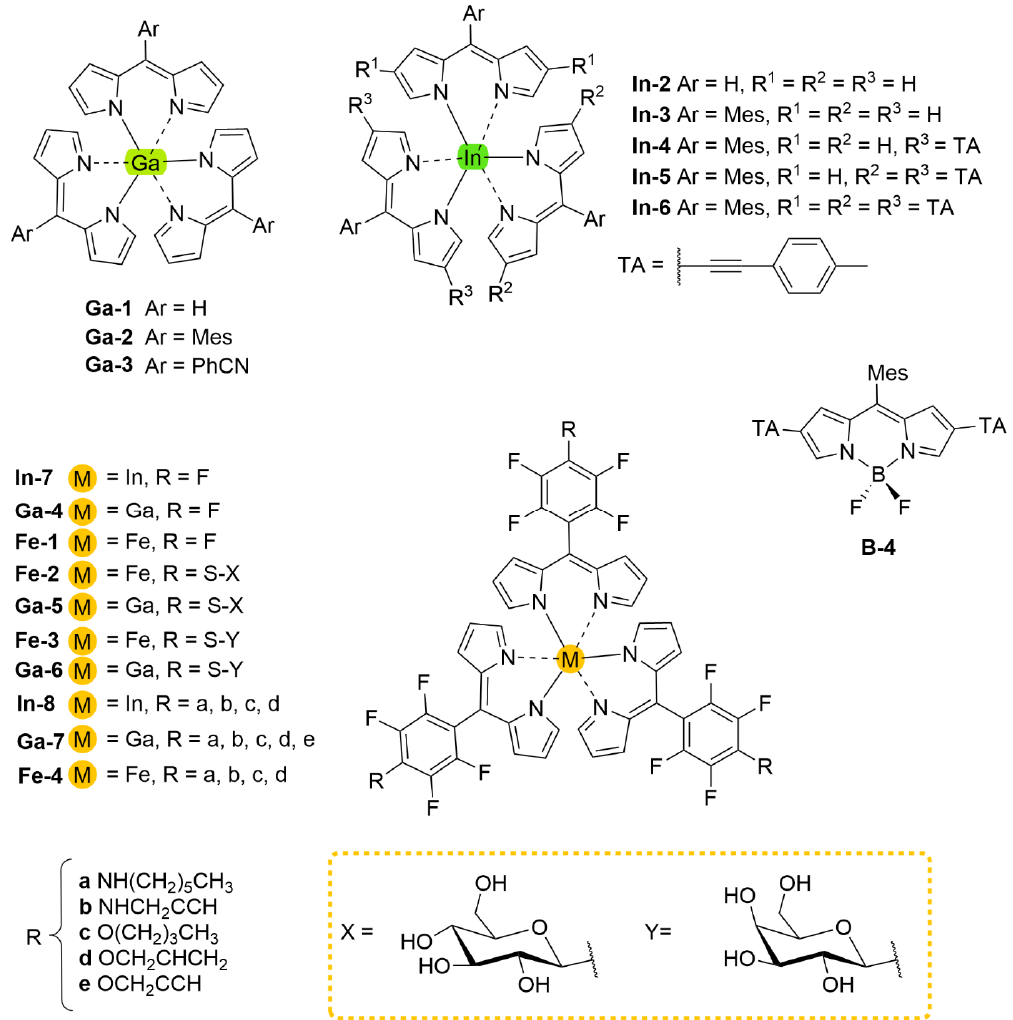
Figure 29. Dipyrrinato-Ga(III) and In(III) as well as Fe(III) complexes reported in literature. The absorption spectra of Ga-2 , Ga-3 and In-3 were very similar to each other (Figure 31b) and display an intense split band with maxima at ca. 450 and 500 nm. At shorter wavelengths a high-energy transition and vibronic structure was observed. This feature was not visible in spectrum of the Zn-2g analogue (see Figure 16) [164]. Both Ga-2 and In-3 were found to be fluorescent ( λ f = 528 and 522 nm, respectively), although less fluorescent than their BODIPY or (dipyrrinato)Zn(II) analogues. The fluorescence quantum yield was determined to be higher for In-3 than Ga-2 ( ϕ f = 0.074 vs. 0.024 in hexanes). However, compared to Zn-2g ( ϕ f = 0.36 in toluene) both complexes are considerably less lumines- cent. This indicates that non-radiative decay pathways (such as IC and ISC) are dominant. The Stokes shifts ( ∆ ˜v = 1113–1220 cm − 1 ) were found to be much larger than for Zn-2g ( ∆ ˜v ≈ 574 cm − 1 ). It was concluded that the most prominent electronic transitions in these complexes are ligand-centered. Ga-3 was not notably luminescent and therefore was not investigated further. Using TCPC the fluorescence lifetimes of Ga-2 and In-3 were obtained in several solvents including toluene, DCM and mixed hexanes (see Table A5, Appendix A). In all solvents tested, except for methylcyclohexane and hexanes, the complexes underwent degradation, possibly via solvolysis. Furthermore, Ga-2 and In-3 were more stable in noncoordinating solvents than Zn-2g . The fluorescence life-time ( τ f ) of Ga-2 was found to be larger than that of In-3 (3.75 ns vs. 1.93 ns) and slightly larger than that of Zn-2g (3.51 ns) in a solvent mixture of hexanes. Although triplet states were not directly